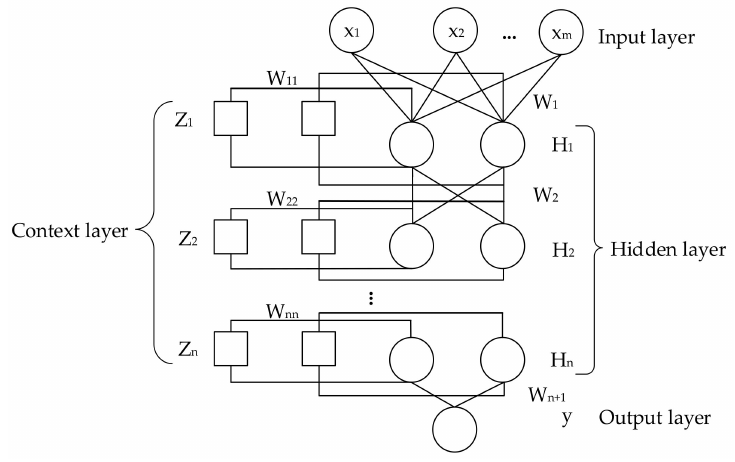
Figure 1. Multi-hidden layer Elman neural